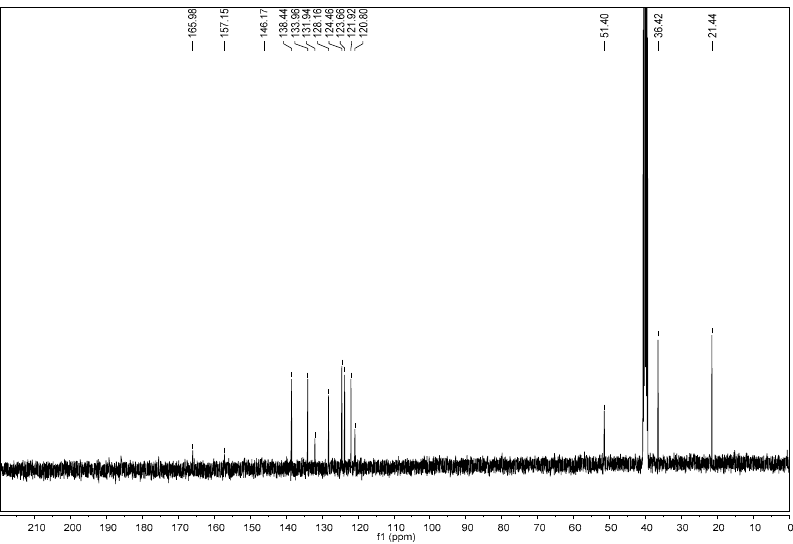
Figure 2. 13 C NMR spectrum of compound 10 .